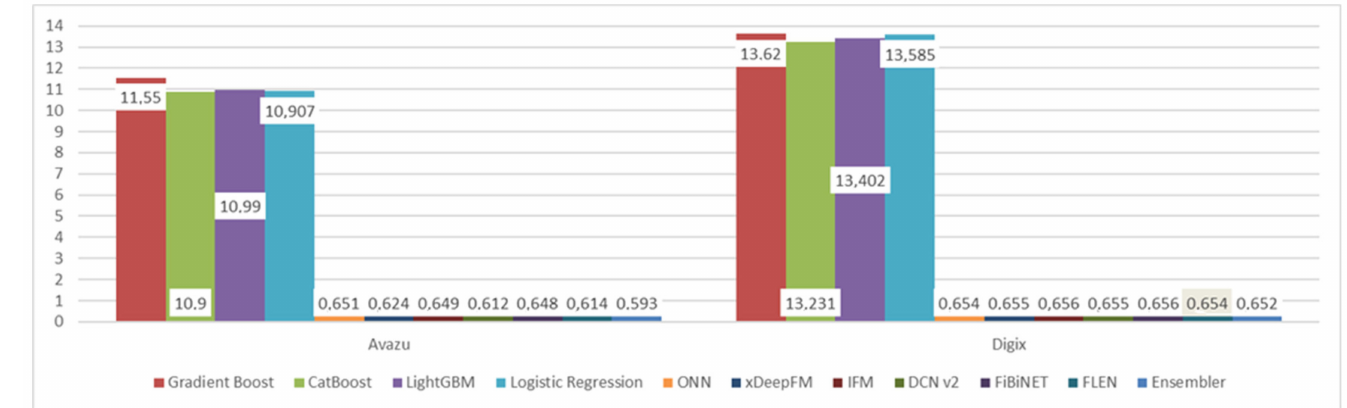
Figure 4. Log-loss scores for the balanced undersampled Avazu and Digix